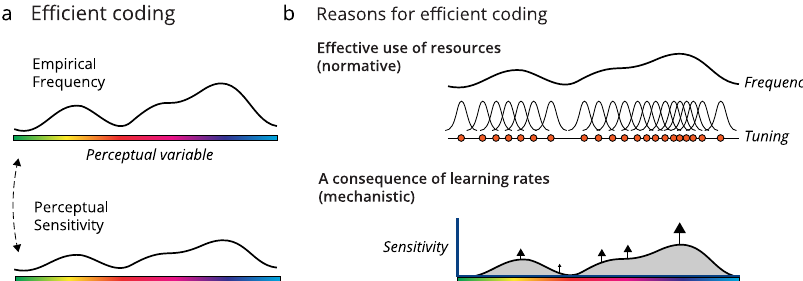
fi nite neural resources to encode a stimulus ensemble. In this work we describe a mechanism for ef fi cient coding due to learning components of the inputs at dif- ferent rates dependent on their